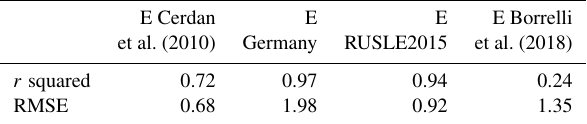
Table 3. Goodness-of-fit results of the comparison of the simulated gross and net erosion rates to those of other studies at subbasin level, taking into account 13 subbasins of the Rhine. RMSE is the root mean square error in 10 6 tyr − 1 . E stands for soil erosion. E Cerdan E E E Borrelli et al. (2010) Germany RUSLE2015 et al. (2018) 0.72 0.97 0.94 0.92 1.35 Table 4. Goodness-of-fit results of the comparison of the simulated gross and net C erosion rates to those of the study by Lugato et al. (2018) in the enhanced and reduced scenario, taking into account 13 subbasins of the Rhine. RMSE is the root mean square error in tyr − 1 . C e stands for gross C erosion, while C d stands for net C erosion. C e C e C d C d enhanced reduced enhanced reduced r squared 0.95 0.95 0.98 0.98 RMSE 7977 13797 9822 Figure 4. (a) Hillslope C erosion rates and (b) C deposition rates compared to the enhanced erosion scenario from Lugato et al. (2018). (c) Hillslope C erosion rates and (d) C deposition rates compared to the reduced erosion scenario from Lugato et al. (2018). The x axis represents bins or evenly spaced ranges between the min- imum and maximum total yearly soil erosion rates of the